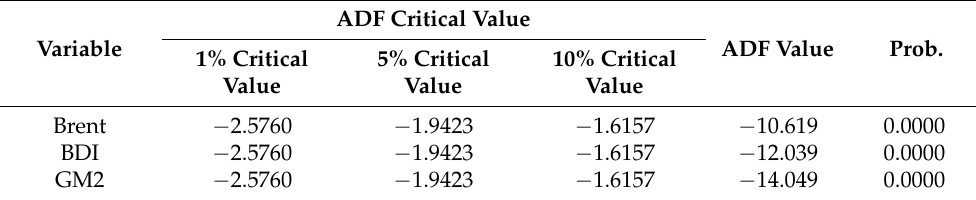
Table 3. Results of variable stability test.